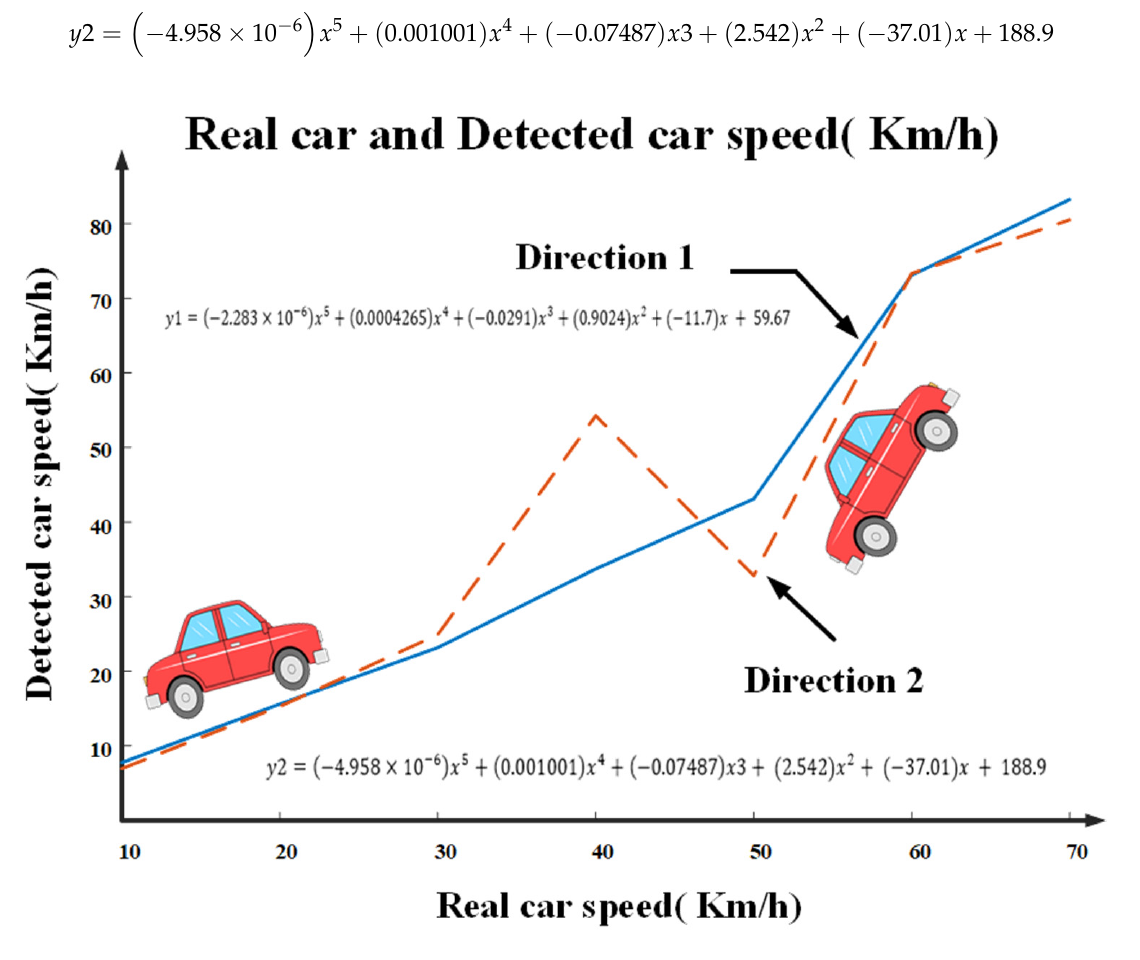
Figure 9. The measured and real vehicle speed differences in two directions.